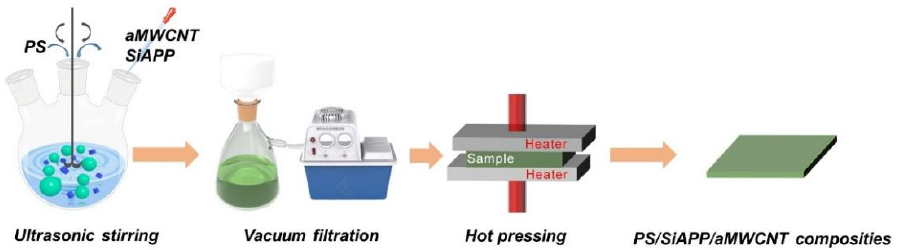
Figure 11. The schematic process for fabrication of PS/SiAPP/aMWCNT composites. Table 3. Formulation of PS/SiAPP/aMWCNT composites. Sample